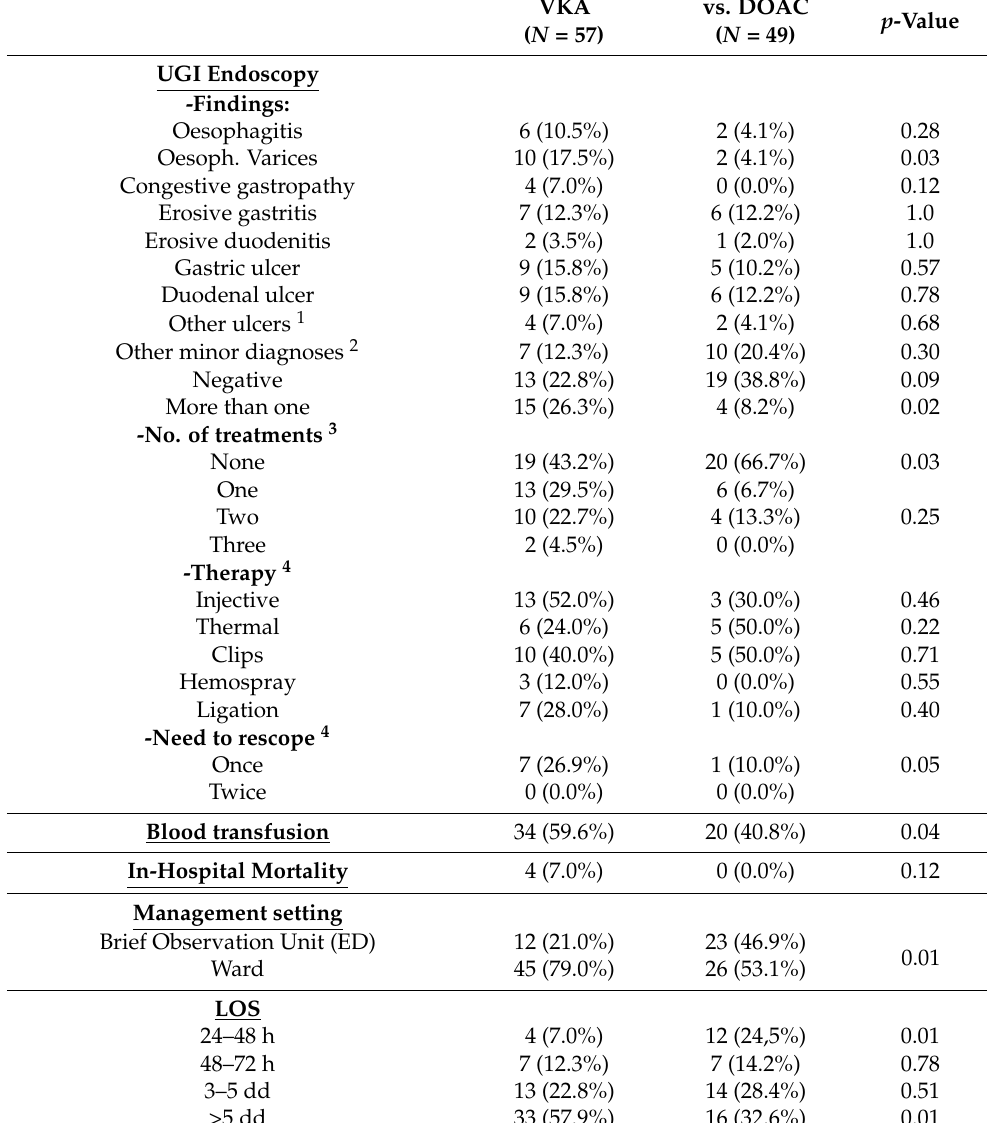
Table 2. Upper GI endoscopy, blood transfusion, in-hospital mortality, management setting, length of